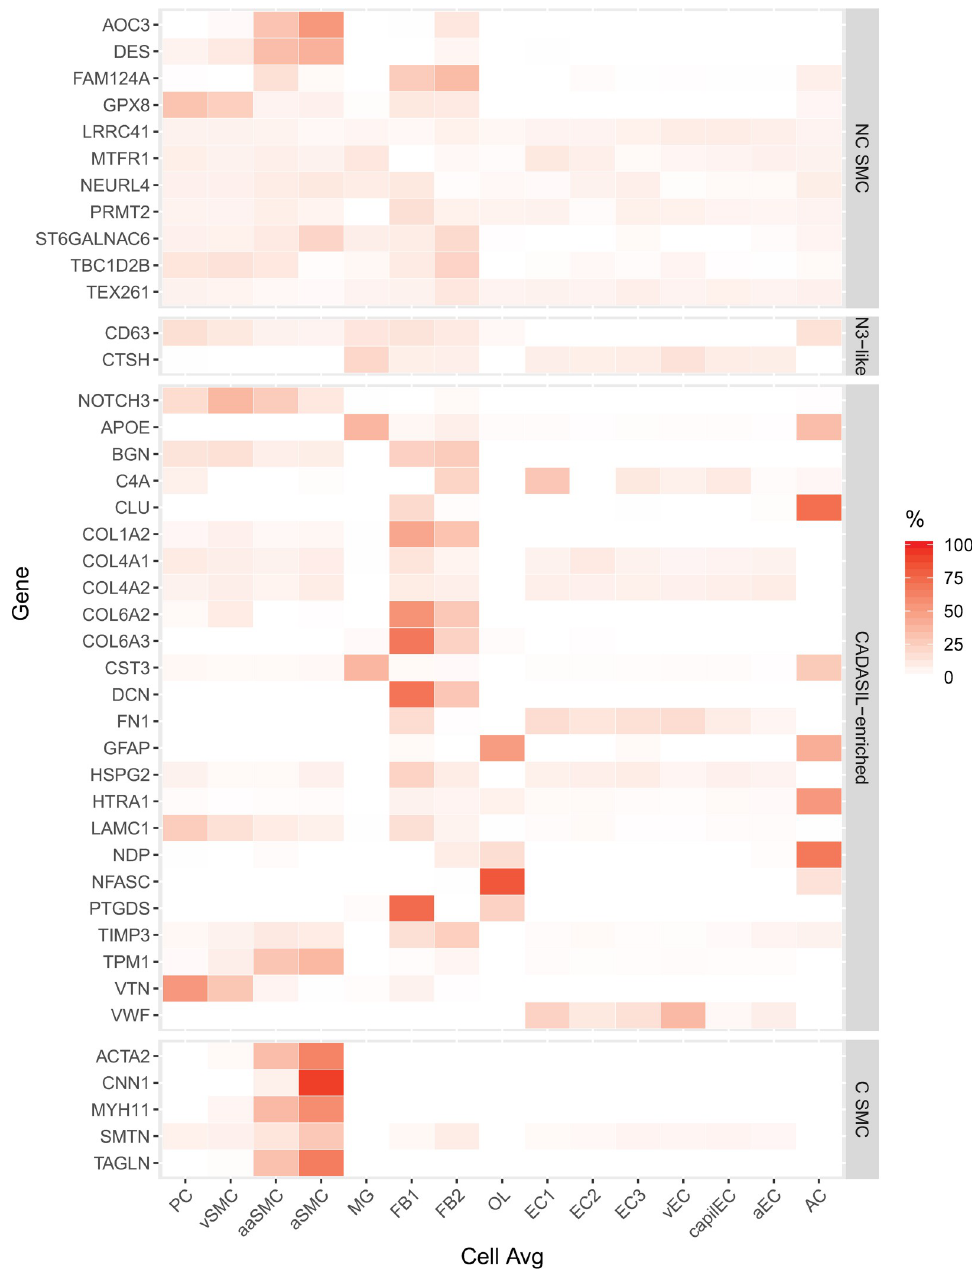
Fig 11. Cellular origin of markers localized in CADASIL vessels. Cell transcriptomic analysis of proteins that accumulate in CADASIL media and of SMC markers. Data was obtained from publicly accessible sets described in [34], in which mouse vessel single cell transcriptomic analysis was performed. All values shown in the heatmap represent fraction of expression normalized to the total number of counts reported across all cell types examined. Marker names are arrayed on the y-axis and cell types along the x-axis. The markers were grouped to cluster non-canonical SMC markers (NC SMC), newly identified NOTCH3 distribution proteins (N3-like; CD63 and CTSH) with NOTCH3, previously identified molecules that were identified in CADASIL vessels [21] (CADASIL-enriched), and canonical SMC markers (C